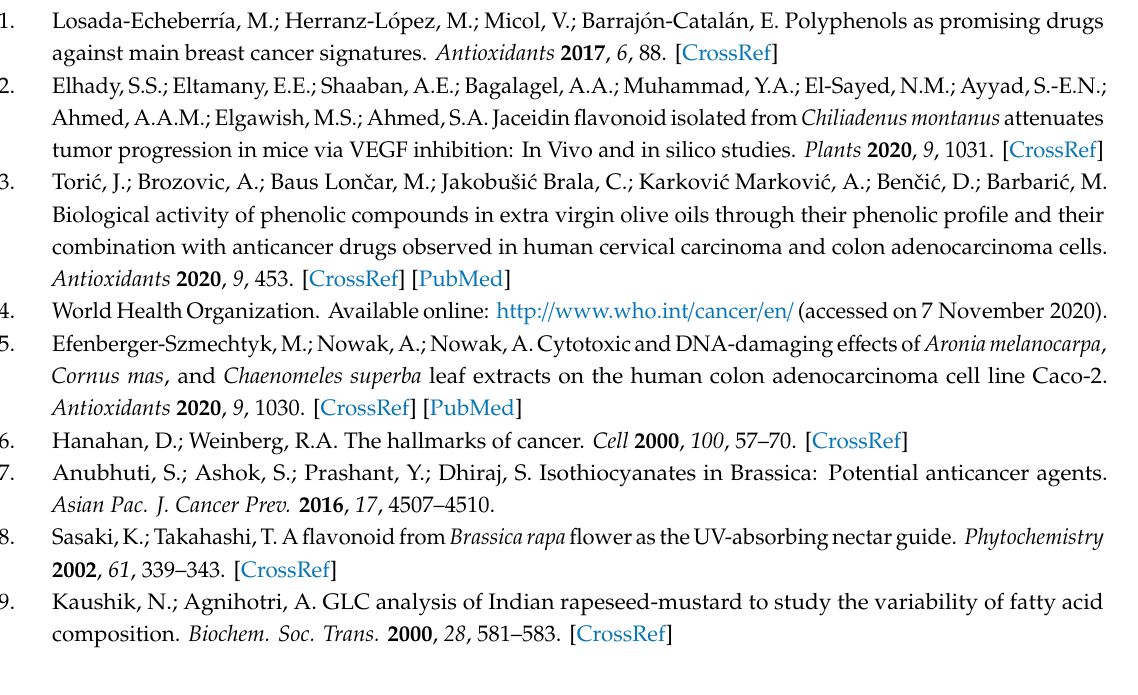
Figure S1. Total ion chromatogram (TIC) recorded in the negative mode for C. annua extract; Figure S2. Base peak chromatogram (BPC) recorded in negative ion mode C. annua extract; Figure S3. Total ion chromatogram (TIC) recorded in the positive mode for C. annua extract; Figure S4. Base peak chromatogram (BPC) recorded in the positive mode for C. annua